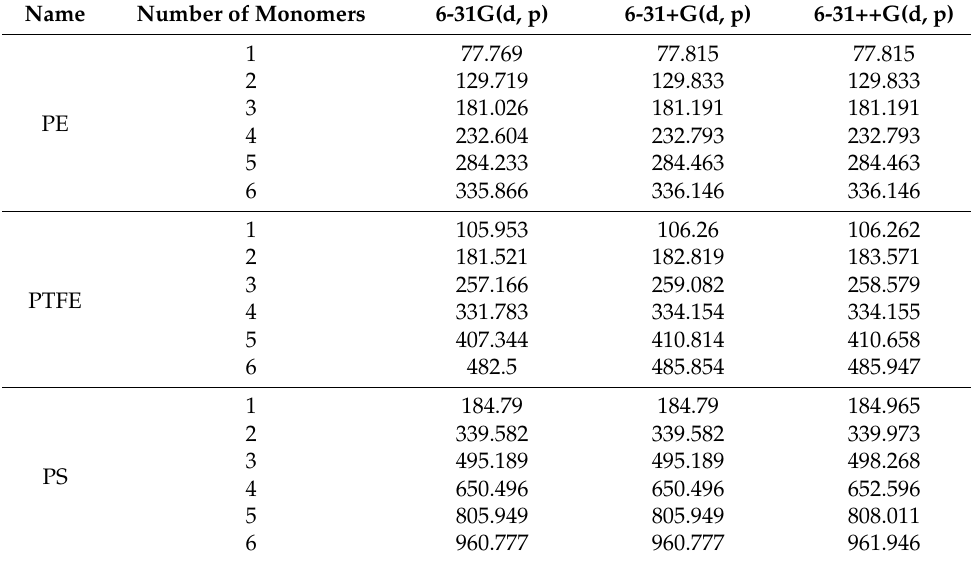
Table 1. The simulated volumes for three typical polymer materials at different basis sets. Here, the volume is given in Å 3 .